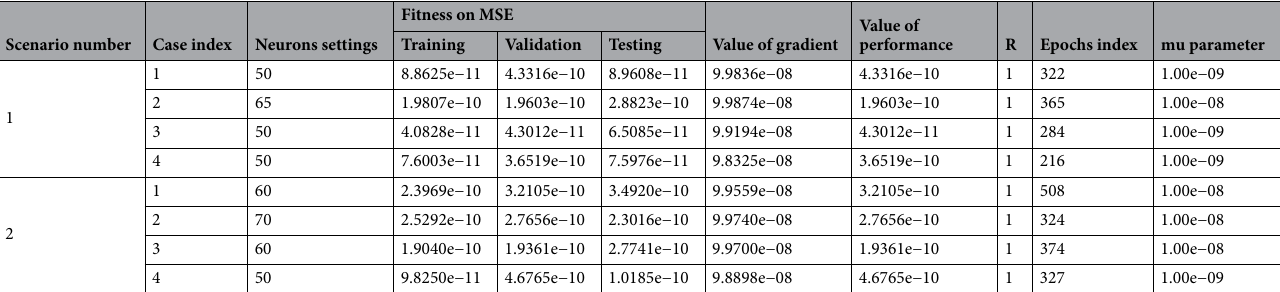
Table 5. Comparative Analysis for all four cases of two scenarios of case study